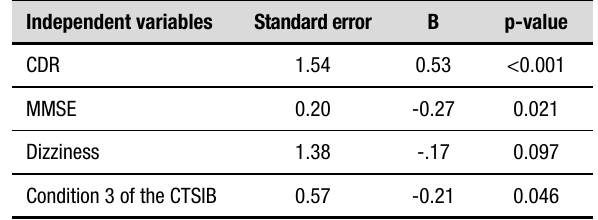
Table 4. Multiple Linear Regression Based on the Functional Activities Questionnaire according to Pfeffer, in a sample of aged people with Alzheimer